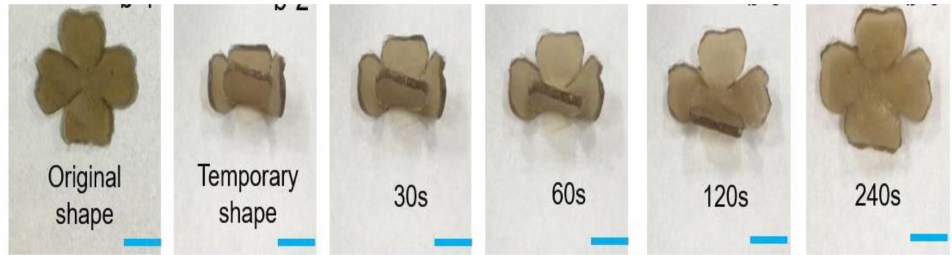
Figure 14. Recovery process of F127DA/PLGA/graphene oxide hydrogel from its temporary shape to its original shape under NIR.